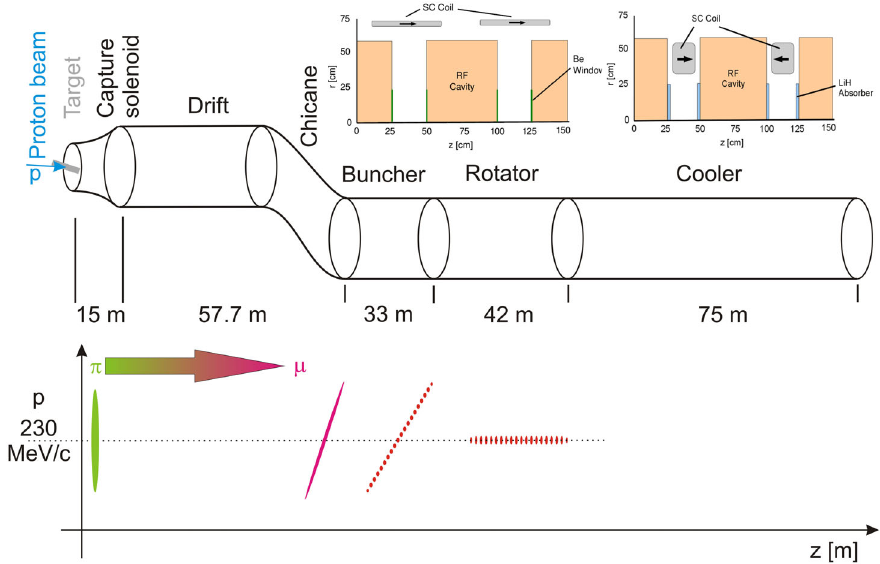
FIG. 6. Schematic of the neutrino factory front-end consisting of a chicane built with solenoids, a buncher and phase-rotation section to adjust the longitudinal phase space to the requirements of the following accelerator, and a cooling section to reduce the transverse emittance to allow for cost-effective